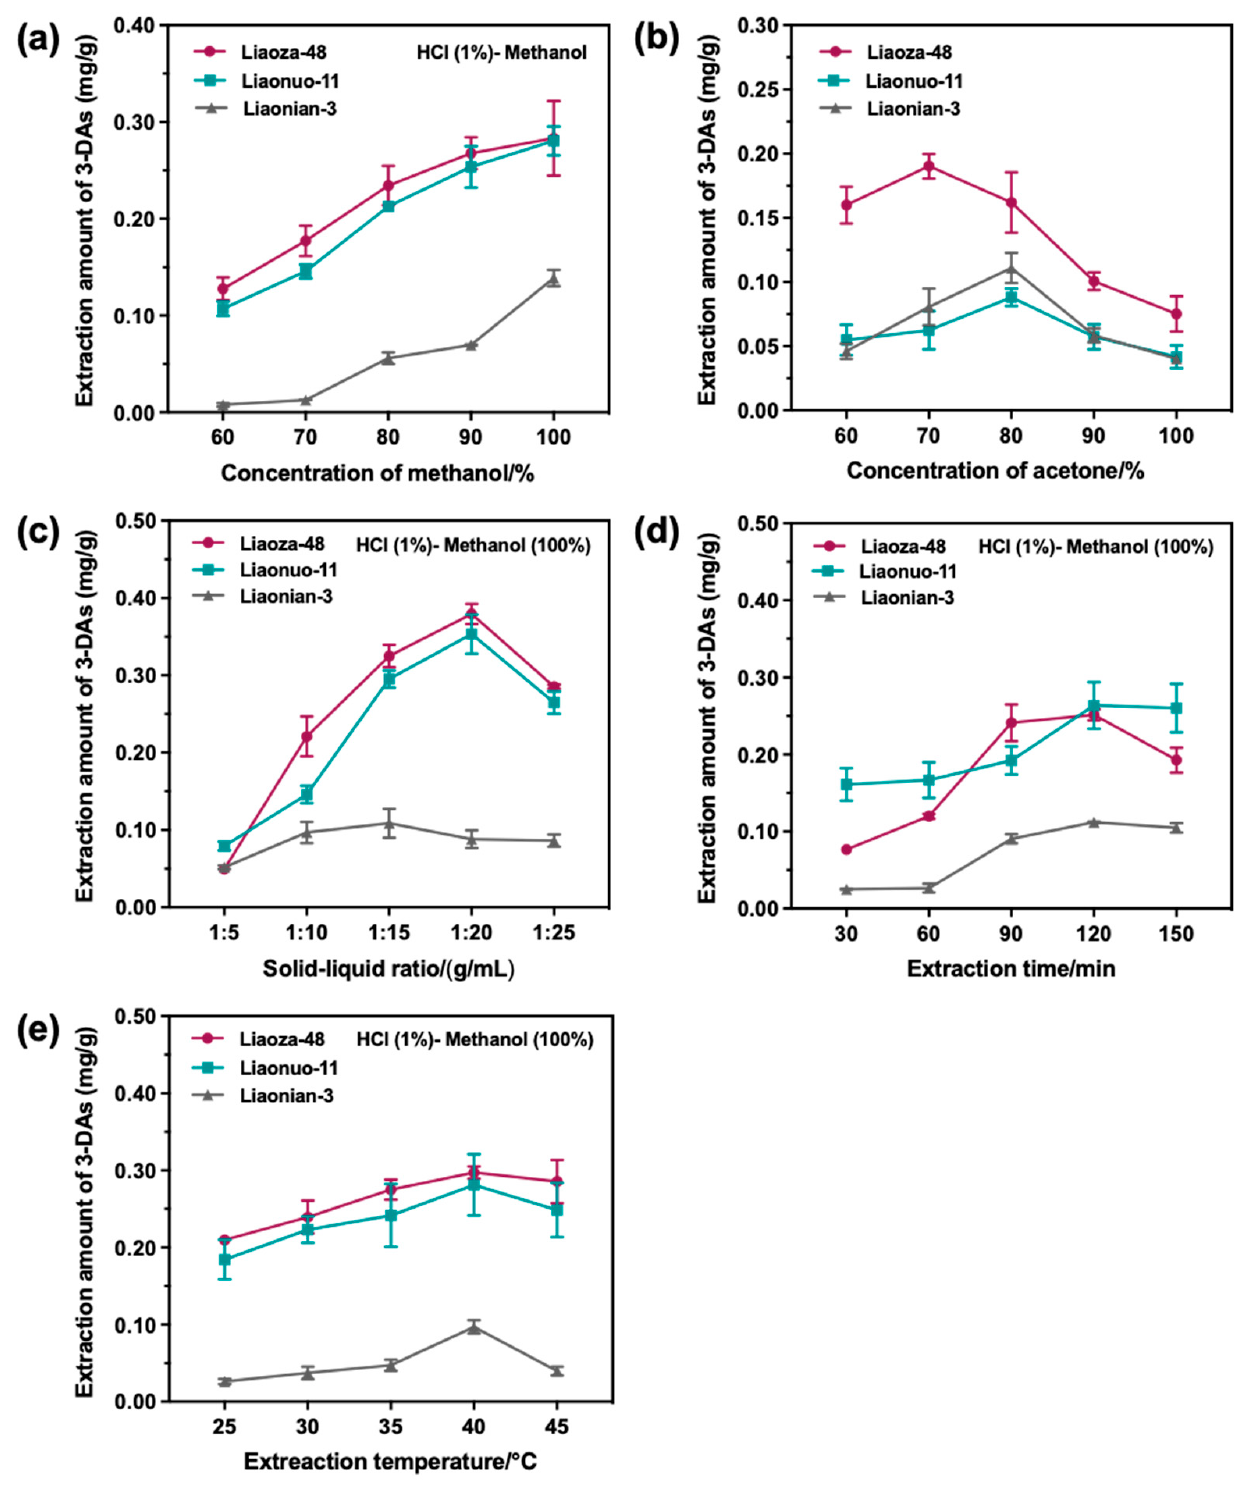
Figure 2. The effects of extraction conditions (( a ): concentration of methanol; ( b ): concentration of acetone; ( c ): solid-liquid ratio; ( d ): extraction time; ( e ): extraction temperature) on the extracted amount of 3-DAs from different sorghum grains.